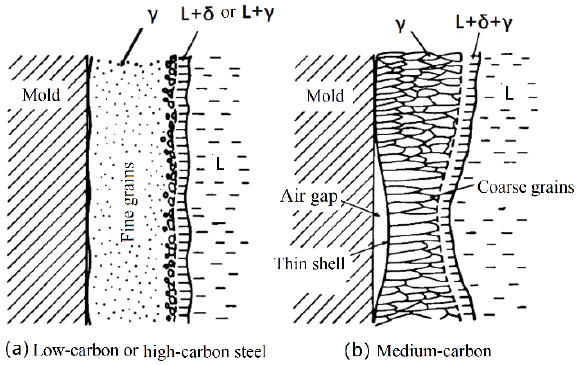
Figure 1. Influence of carbon content on shell characteristics.